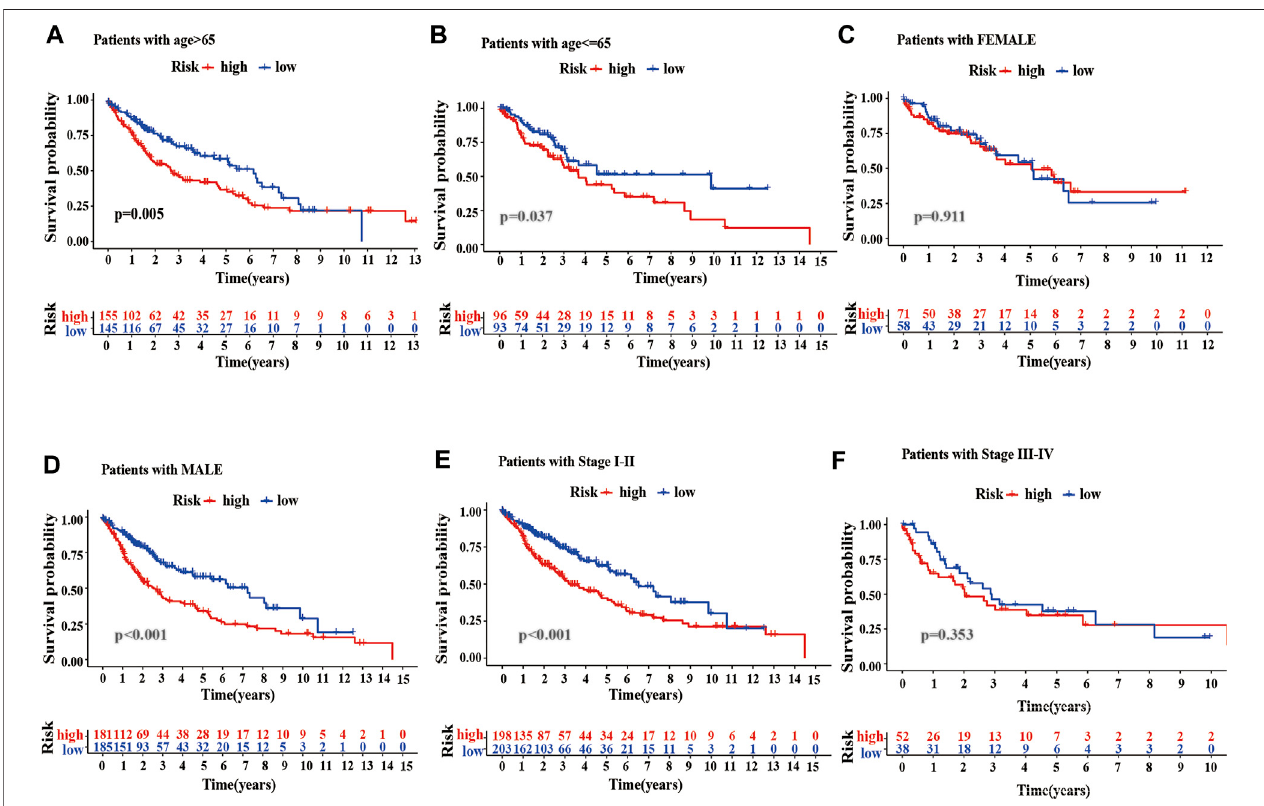
FIGURE 9 | Strati fi ed analysis of survival based on clinicopathological features. (A – F) The predictive ability of m 6 A-LPMs in multiple subgroups of LUSC patients, including the different ages: ＞ 65 (A) or ≤ 65 (B) , different sexes: female (C) or male (D) , different stages: I-II (E) or III-IV (F) . LUSC, lung squamous cell carcinoma;